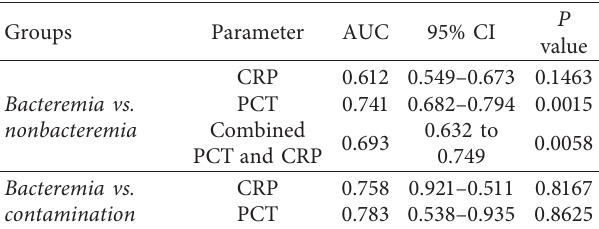
Table 3: PCT and CRP area under ROC curve value between bacteremia and nonbacteremia